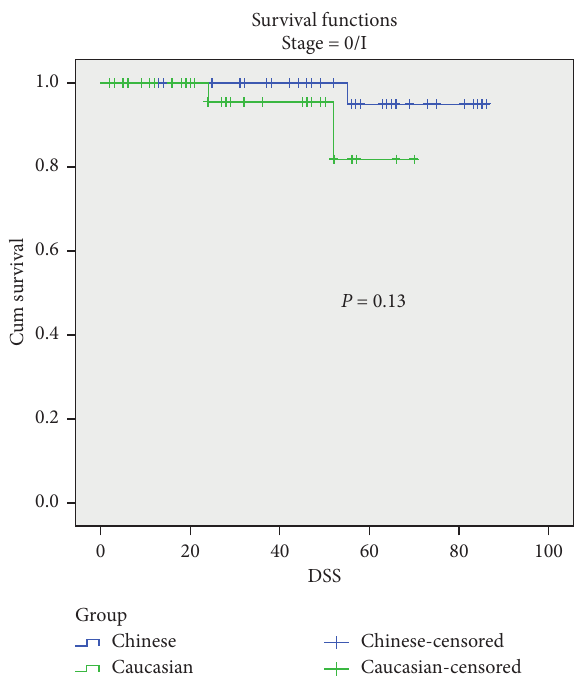
Figure 1: Stage-stratified 5-yr DSS in Chinese and Caucasian groups. Stage 0/I, p � 0 . 13.